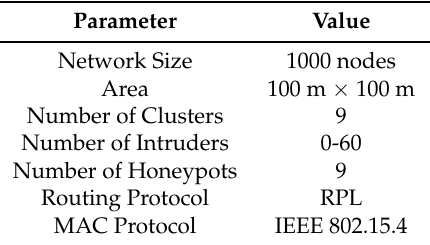
Table 1. Simulation